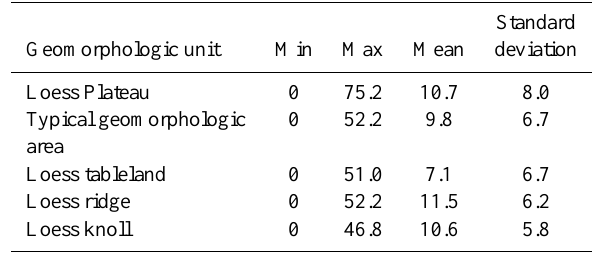
Table 1. Numerical statistics for the slope of different geomorpho- logic units ( ◦ ).